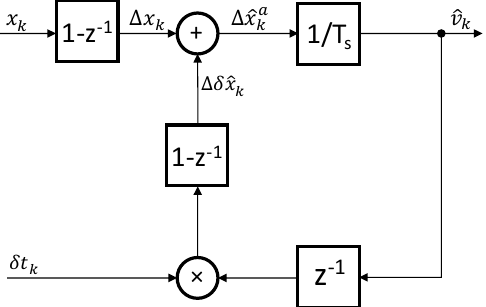
Figure 5. The block scheme of the division-less MT-type algorithm of the second order (DLMT2) filter [52].